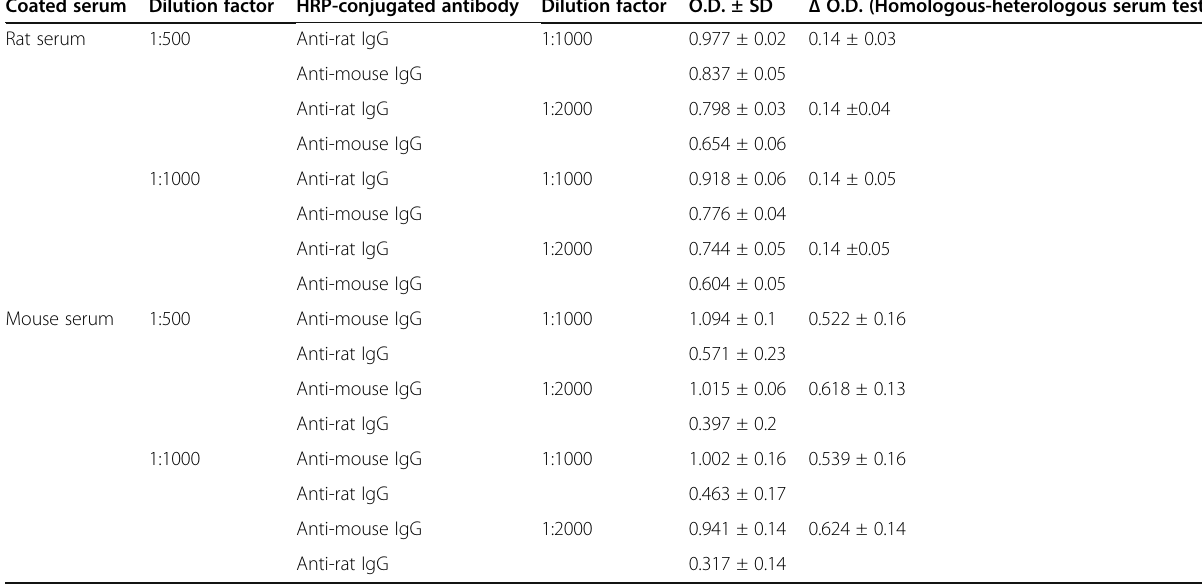
Table 1 Numerical O.D. values recorded for the reaction between coated mouse and rat serum with HRP-conjugated anti-IgG antibodies, showing working dilutions, respective O.D. and calculated Δ